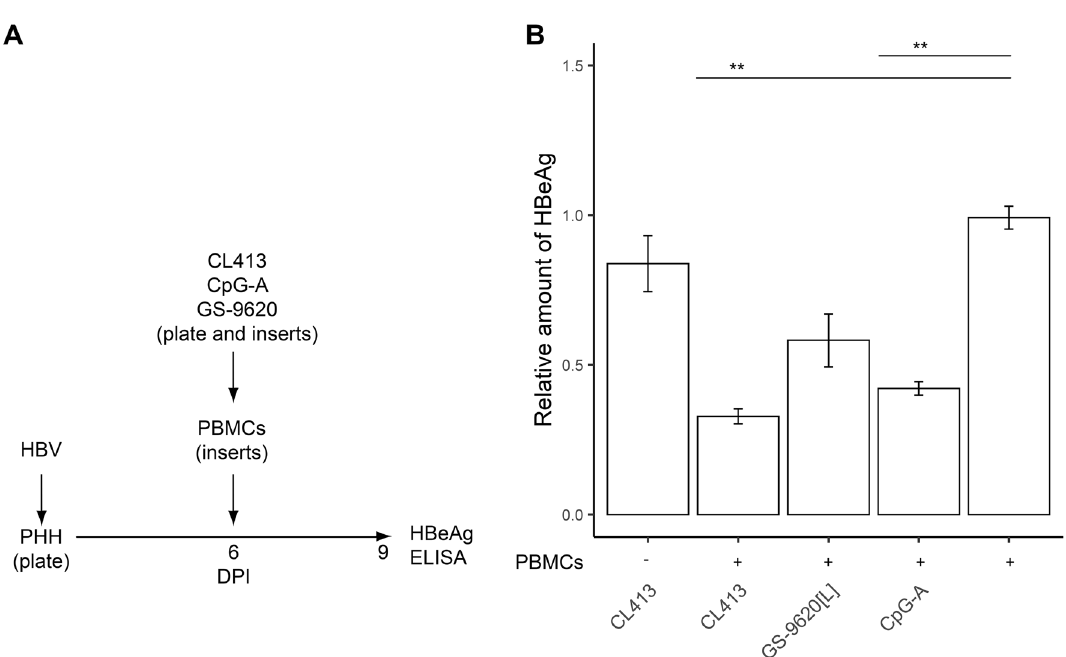
Figure 4. Inhibition of HBeAg production from HBV-infected PHH by coculture with TLR2/7, TLR7 or TLR9 agonist-stimulated PBMCs. ( A ) Experimental flow chart. PHH were infected with HBV and kept in culture for 6 days before a Transwell insert containing PBMCs stimulated with the TLR2/7 agonist CL413 (5 µg/ml), TLR9 agonist CpG-A (4 µg/ml), or TLR7 agonist GS-9620[L] (50 nM) was added. ( B ) Production of HBeAg was normalized to production of HBV-infected PHH cells cocultured with non-stimulated PBMCs. In one parallel, a culture of HBV-infected PHH was exposed to CL413 in the absence of PBMCs. Data are shown as mean ± SEM of three biological replicates with PHH from two donors (N = 2). ** p < 0.01, Mann–Whitney–Wilcoxon pairwise test, p value adjusted by BH